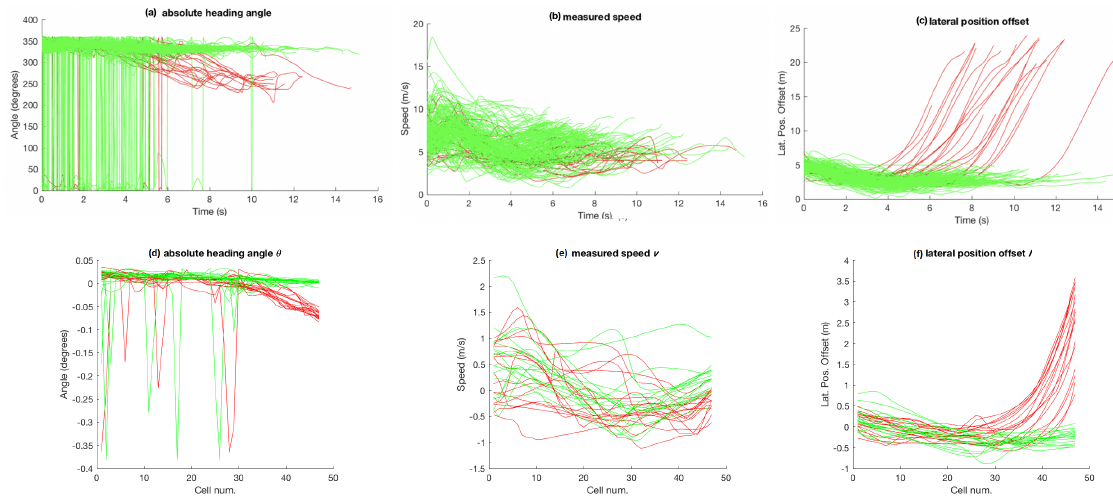
Attribute values for the car-turning dataset: ( a – c ) observations across time; and ( d – f ) grid-cell-wise zero-mean and unit-variance normalized attribute values.